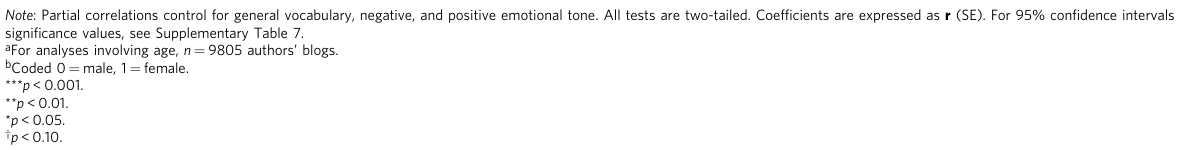
Pearson correlations with Partial correlations with Pearson correlations with negative EV negative EV positive EV